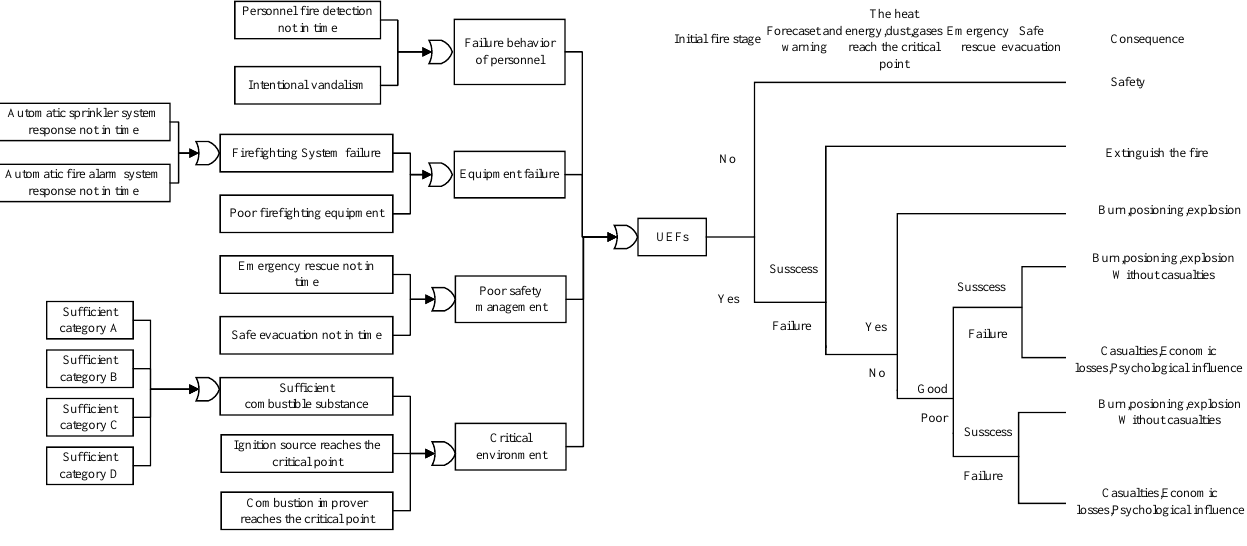
Figure 5. EPB for UEFs.